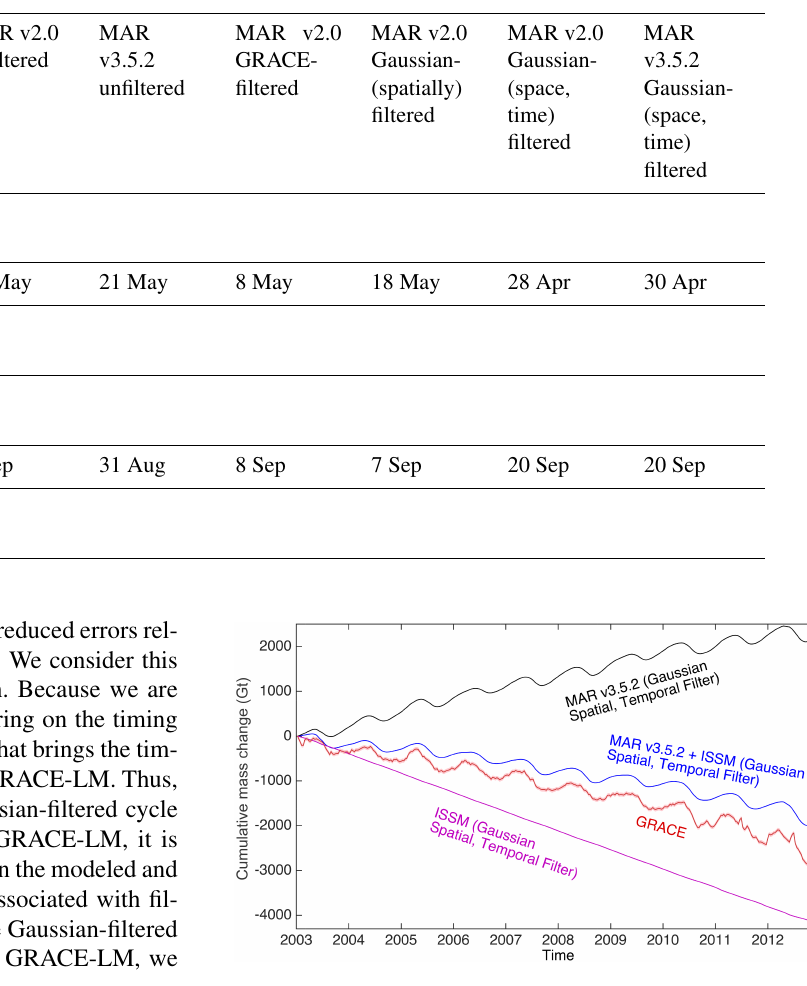
Figure 6. Cumulative GrIS mass change for the January 2003– December 2012 period from GRACE-LM, MAR SMB, ISSM DMB, and the combined results of MAR v3.5.2 + ISSM. Spatial and temporal Gaussian filtering is applied to model outputs. The estimated error associated with the GRACE-LM solution is small relative to the overall trend, and is denoted with pink shading sur- rounding the GRACE-LM time